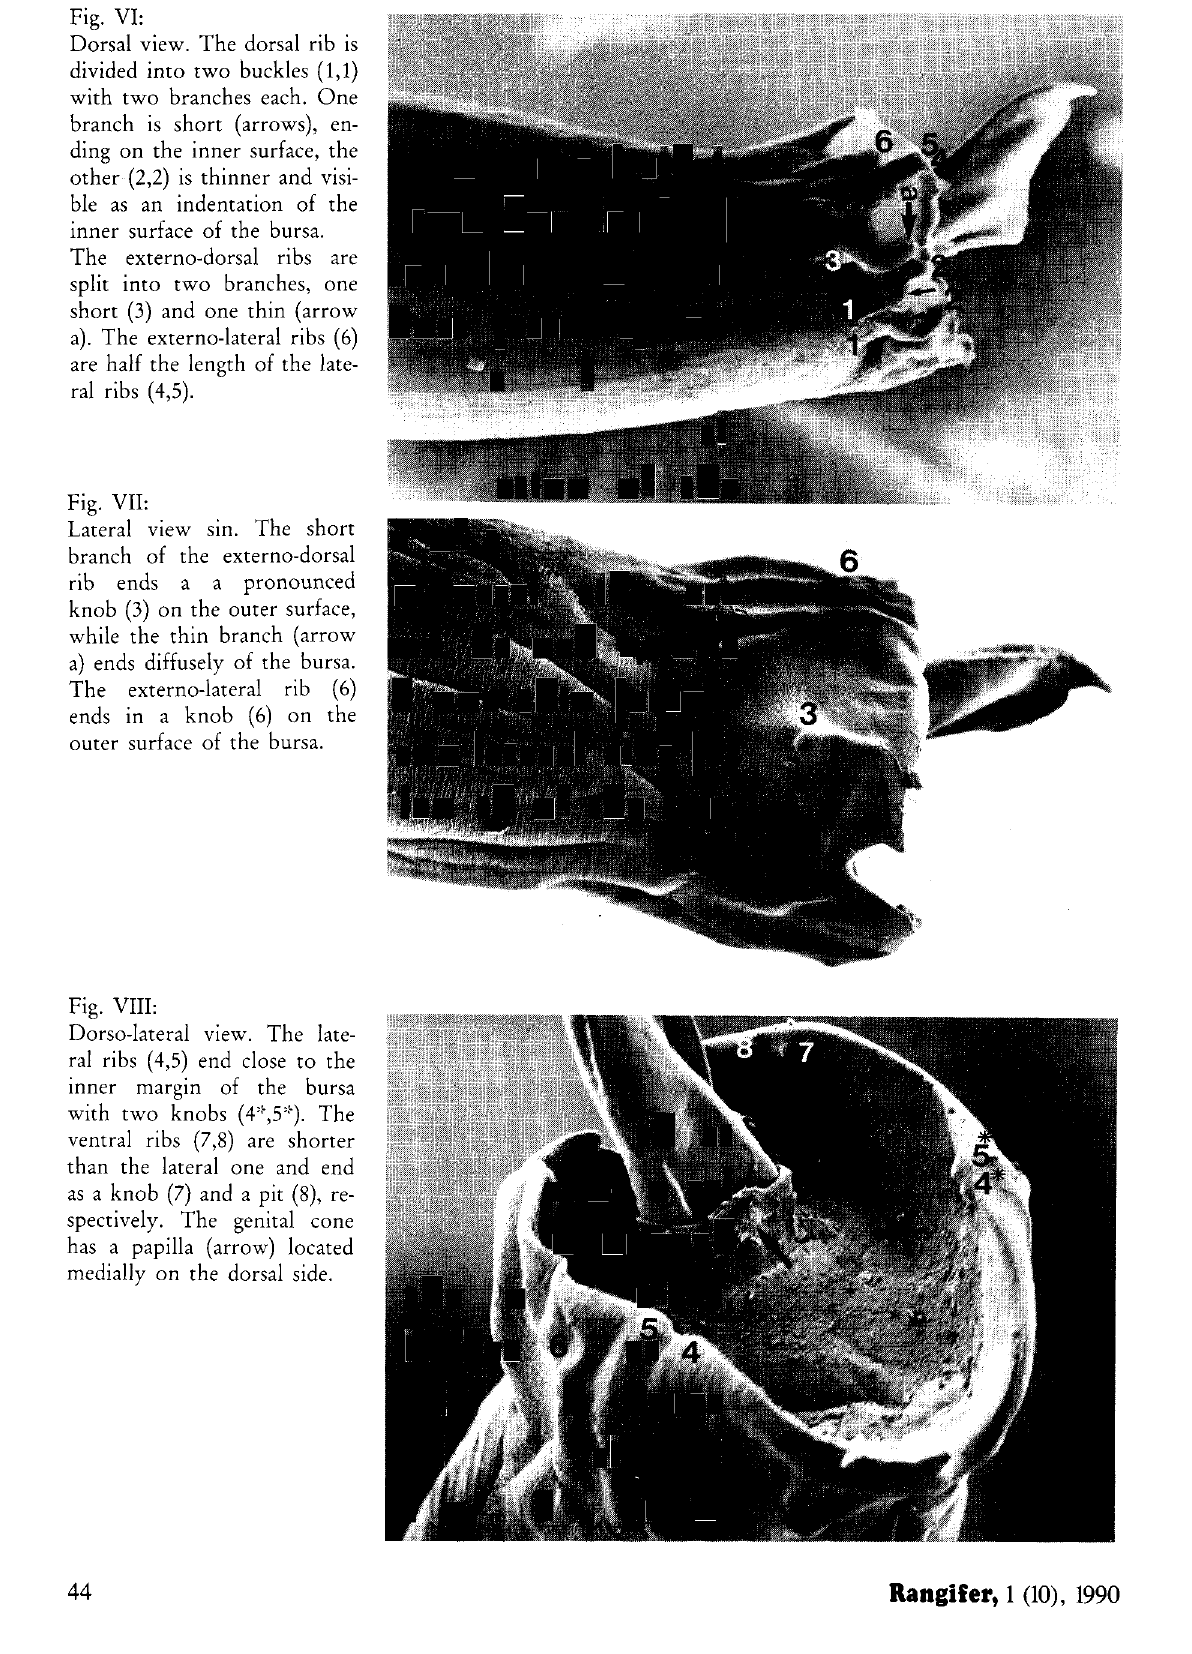
Fig. VI: Dorsal view. The dorsal rib is divided into two buckles (1,1) with two branches each. One branch is short (arrows), en ding on the inner surface, the other (2,2) is thinner and visi ble as an indentation of the inner surface of the bursa. The externo-dorsal ribs are split into two branches, one short (3) and one thin (arrow a). The externo-lateral ribs (6) are half the length of the late ral ribs (4,5).